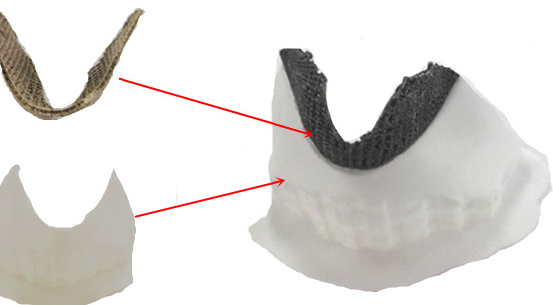
Figure 10. Matching test chart of thyroid cartilage prosthesis formed by